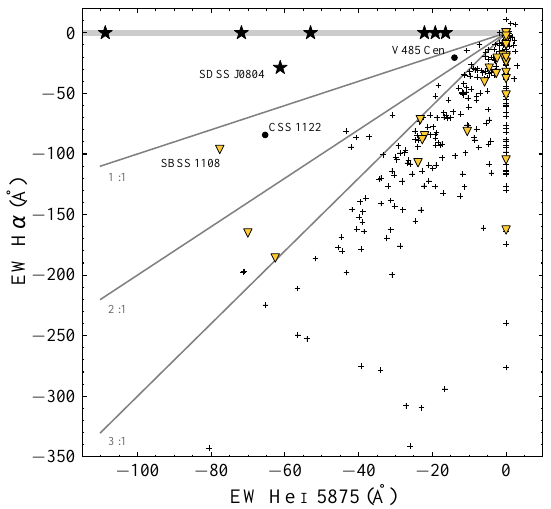
Figure 2: EW of He i 5875 versus H α for our CV sam- ple (triangles), and the CV population from the SDSS (crosses). The star symbols represent the AM CVns from our sample, which fall on the EW(H α ) = 0 line. Also plotted are lines showing H α to He i 5875 EW ra- tios; CVs with unusually low EW ratios are labelled, V485 Cen is shown for comparison. The position of the AM CVn SDSS J0804+1616 is due to strong He ii 6559